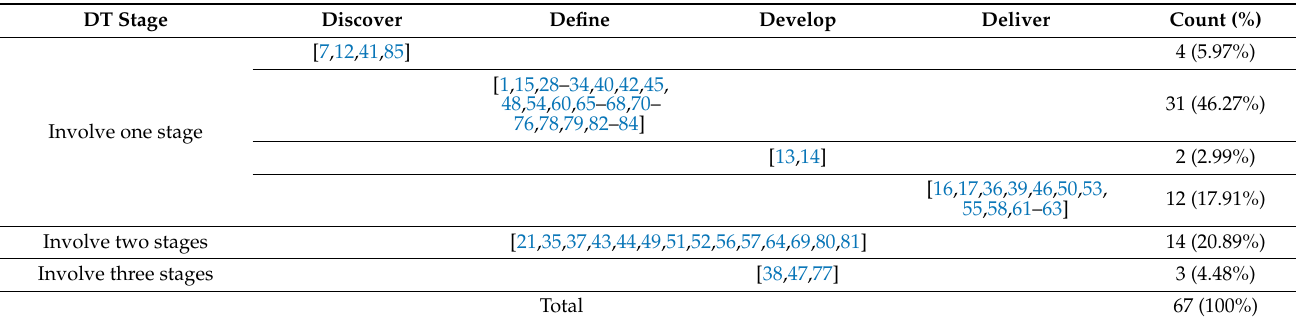
Table 4. Summary of the study stage in the DT process.